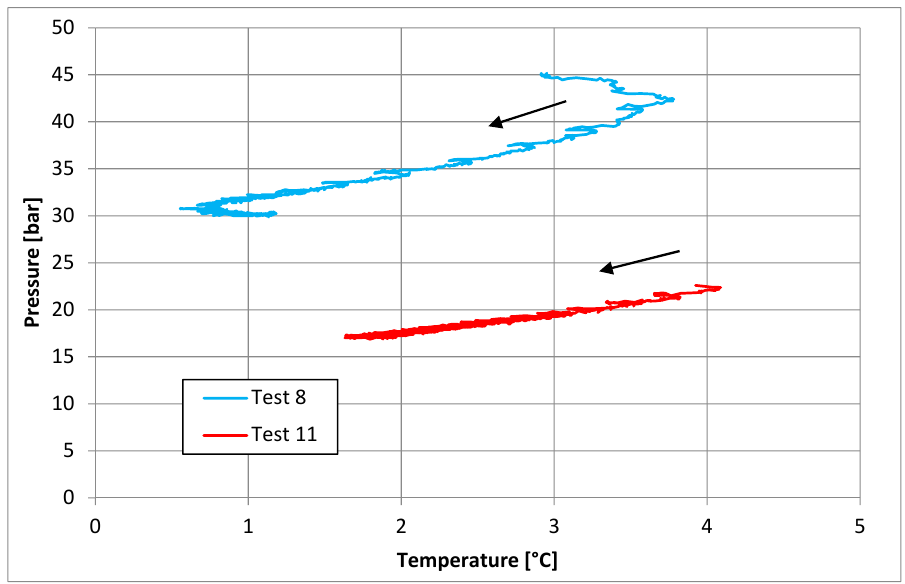
4 , and Test 10, performed with CO 2 . Processes 2020 , 8 , x FOR PEER REVIEW